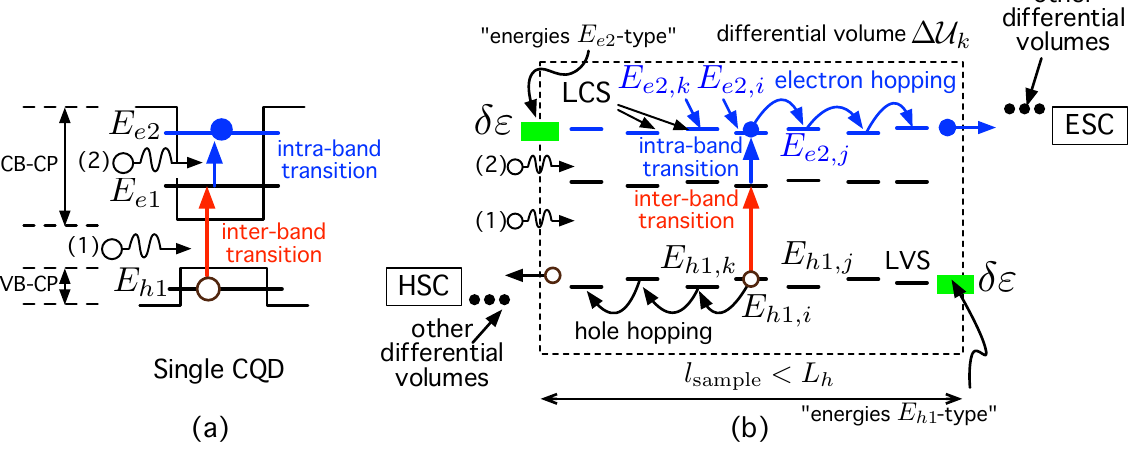
Figure 3. ( a ) Single CQD showing its CB and VB confinement potentials (CB-CP, VB-CP), respectively. E e 1 is the energy level associated to the 1S e orbital, while E e 2 is the one associated to the 1P e state. They are levels corresponding to electron states CB-CP. E h 1 stands for the first hole energy level in the VB-CP, 1S h being its corresponding quantum state. ( b ) Any of the differential volumes ∆ U k in which the cell is sub-divided. Once sub-band-gap photons (1) and (2) are absorbed, generating an extra electron-hole pair, the electron moves by hopping towards its selective contact (ESC) through E e 2 -type levels, while the hole moves by hopping towards its selective contact (HSC) via E h 1 -type